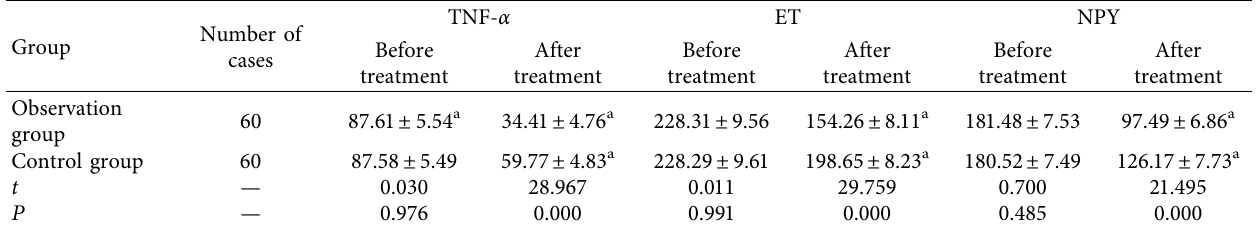
Table 2: Comparison of the levels of TNF- α , ET, and NPY in the two groups of patients ( x − ± s , pg/mL). Group